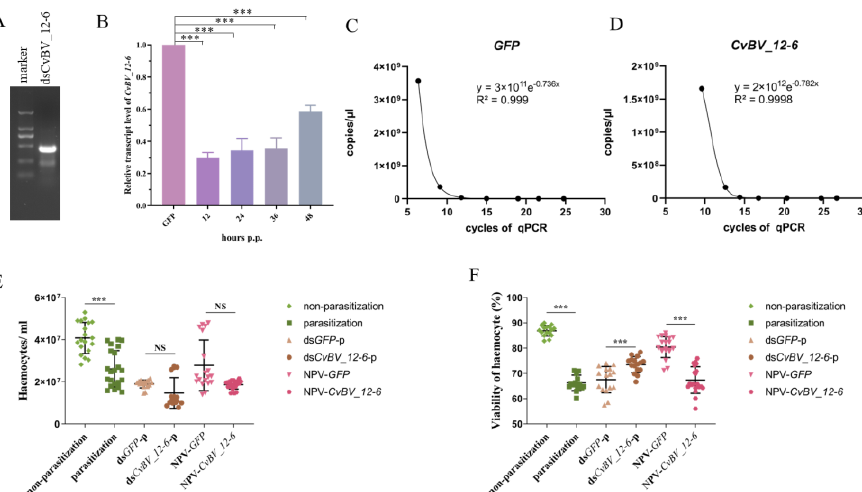
Figure 4. The effect of CvBV_12-6 on hemocytes of the P. xylostella host. ( A ) The biosynthesis of dsRNA of CvBV_12-6 was detected by agarose gel electrophoresis. ( B ) The RNA interference efficiency was measured by qPCR. ( C , D ) A standard curve was used to calculate the titer of the recombinant baculovirus as determined by qPCR. ( E , F ) The effect of CvBV_12-6 on the hemocyte count and the hemocyte viability in P. xylostella . The hemolymph of P. xylostella was collected 24 h after parasitization, RNAi or injection of NPV. Then, 19.5 µ L of trypan blue working solution was mixed with 0.5 µ L hemolymph, and then added to a cell counting plate. Count Star 1.0 software was used to automatically analyze the cell number and viability. ds CvBV_12-6 -p: ds CvBV_12-6 was injected into third instar larvae, and parasitization was performed immediately; ds GFP -p was used as the negative control. NPV- CvBV_12-6 : injection of NPV- CvBV_12-6 into third instar larva; NPV- GFP was used as the negative control. Each treatment group included more than 30 larvae (n >15). Data are presented as the mean ± SD. Differences among samples were evaluated for significance via Tukey’s test (*** , significant difference for a p value < 0.001).